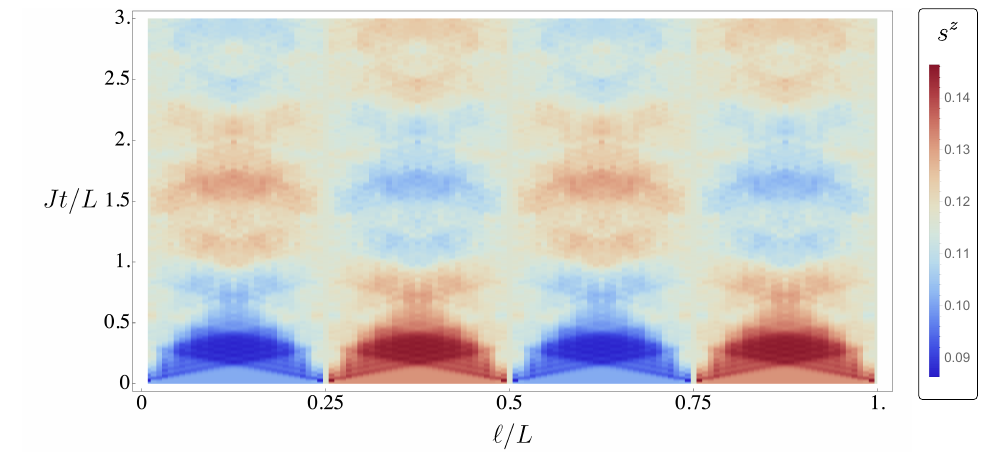
( t ) in a chain with L = 128 (cid:96) } , with β = J − 1 , β , β , β L R L R L